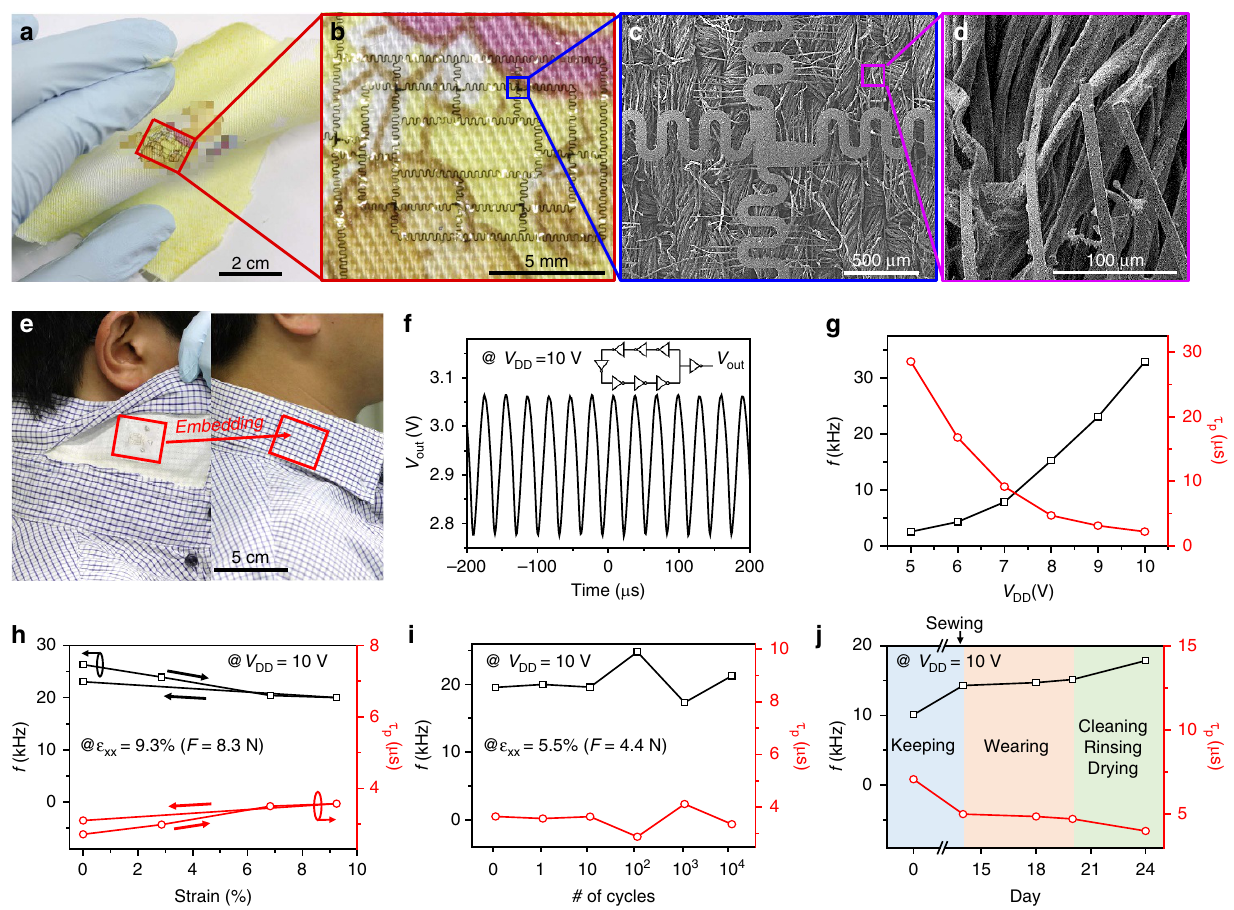
Figure 6 | IGZO-based 7-stage ring oscillator transferred onto textiles. ( a – d ) Photograph and magnified SEM images of the device transferred on a handkerchief. ( e ) Photographs of the device transferred onto a piece of cloth and sewn inside the collar of a shirt. ( f , g ) Representative output voltage waveform at V DD ¼ 10V ( f ) and oscillation frequency and propagation delay versus different V DD values ( g ) of the device. ( h – j ) Oscillation frequency and propagation delay upon tensile deformation ( h ), after repeated stretching (up to B 4.4N) and releasing ( i ), and after wearing and cleaning/rinsing/drying ( j